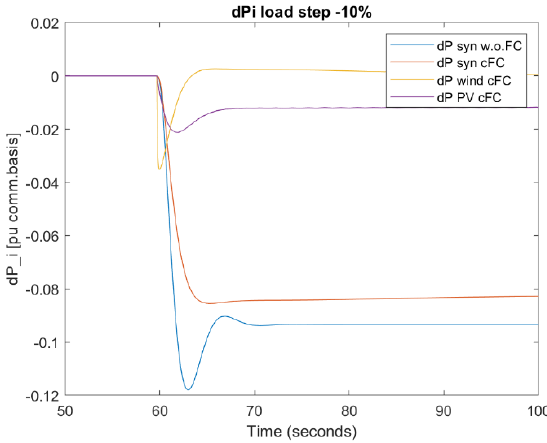
Figure 15. Generator power variations in Simulation